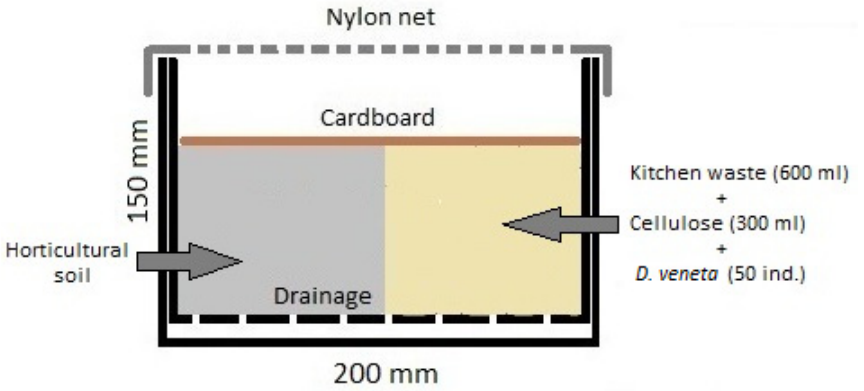
Figure 2. Schematic of a vermireactor, modified from P ą czka et al. [37]. To maintain appropriate humidity within the vermireactors, they were wetted every 10 days with the same amount of tap water (pH—7.5, conductivity—486 μ S cm − 1 , nitrates (V)—8.5 mg ∙ dm − 3 , nitrates (III)—0.01 mg ∙ dm − 3 , Mg—14.2 mg ∙ dm − 3 , water hardness—231